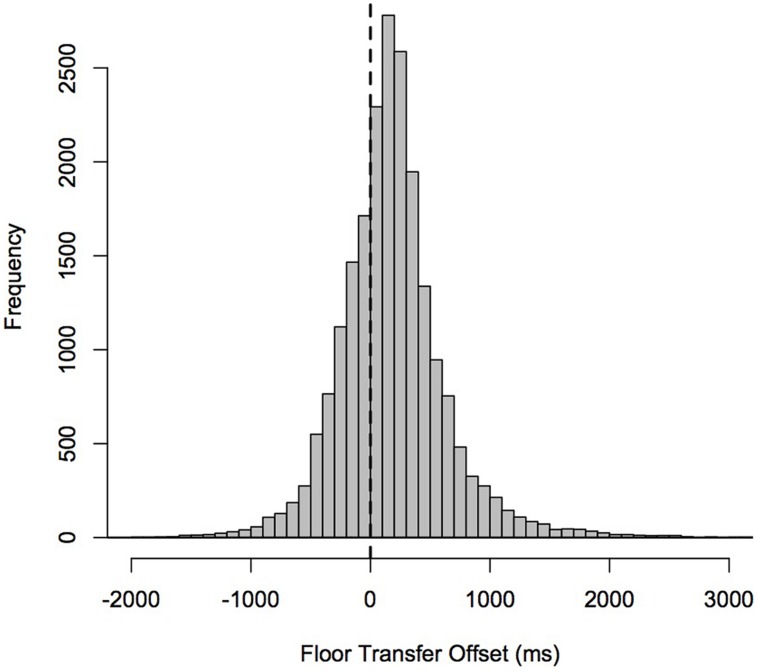
Histogram of floor transfer offsets (FTOs) in the Switchboard Corpus (Godfrey et al., 1992; Calhoun et al., 2010, see Section 5.2.1 for details). Each bin has a size of 100 ms.